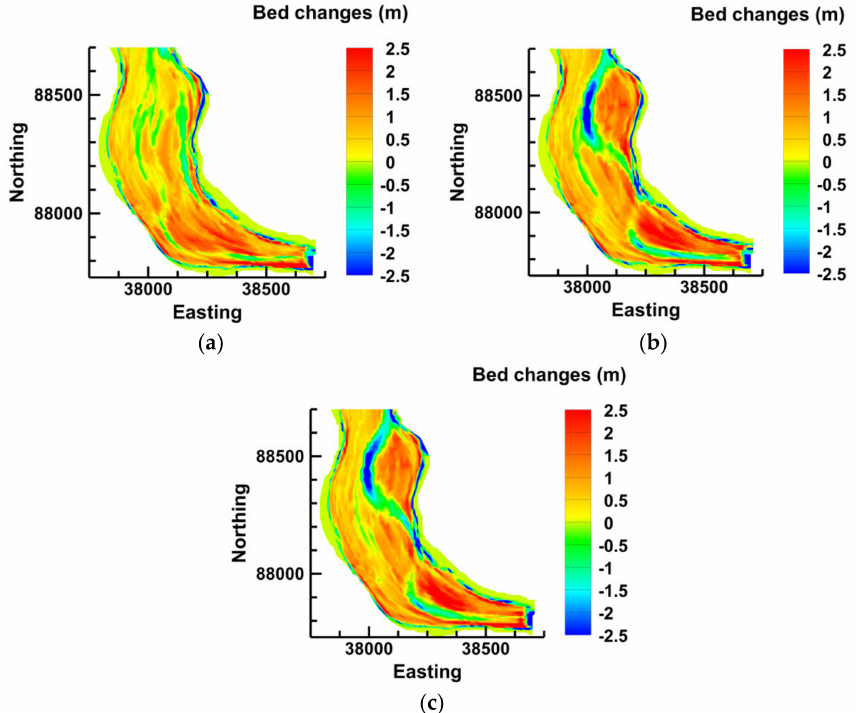
Figure 7. Plan view of the calculated bed changes in the study segment in the Unazuki Reservoir under the ( a ) ADF 150 scenario; ( b ) ADF 250 scenario; and ( c ) ADF 300